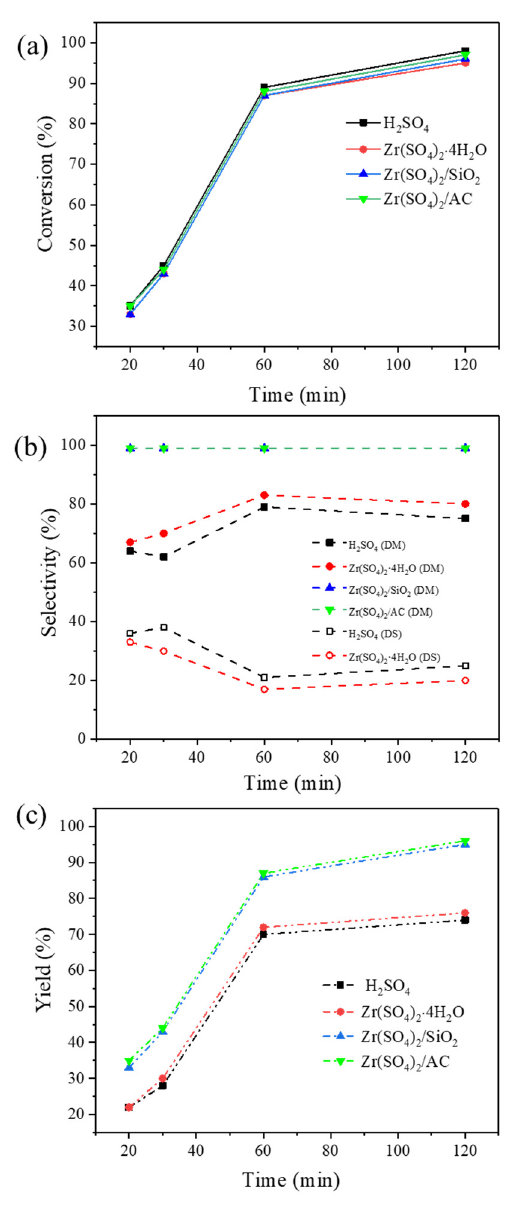
Figure 2. Dependence of ( a ) conversion of malic acid, ( b ) selectivity of dimethyl malate (DM) and 2-methoxy dimethyl succinate (DS) and ( c ) yield of dimethyl malate (DM) on reaction time over H 2 SO 4 , Zr(SO 4 ) 2 · 4H 2 O, Zr(SO 4 ) 2 / SiO 2 , and Zr(SO 4 ) 2 / AC catalysts. Reaction conditions: Methanol (5 mL), malic acid (1 g), catalyst amount (0.1 g), reaction time (2 h), reflux temperature, stirring speed (600 rpm).